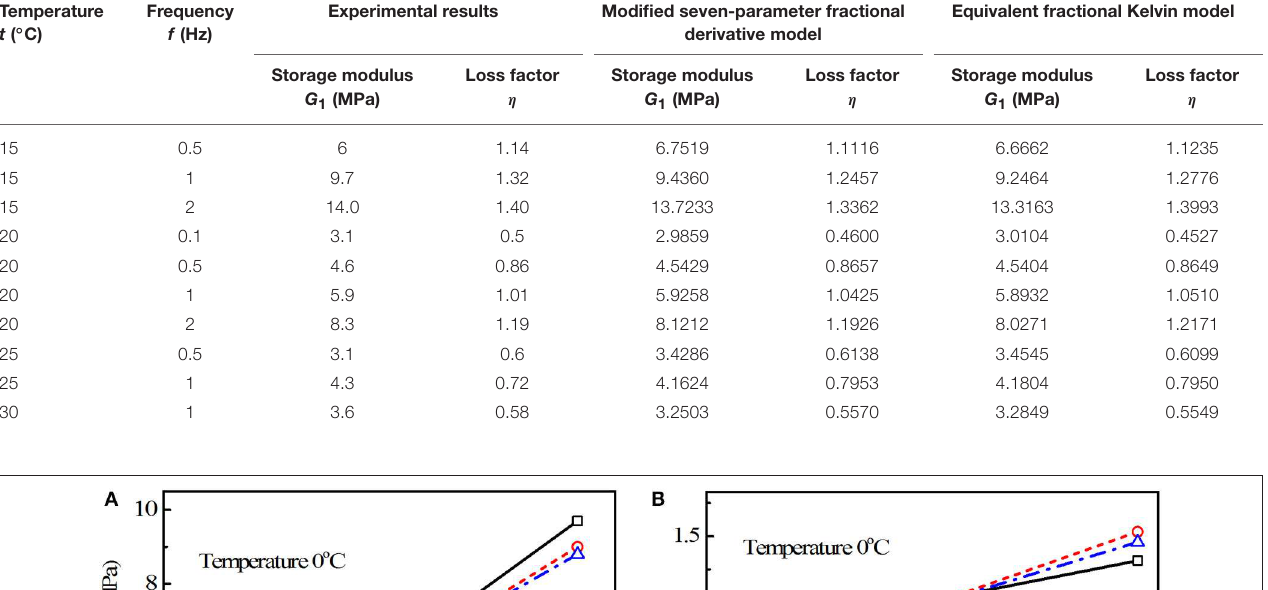
TABLE 5 | Experimental and numerical results comparison for Zn22 viscoelastic material. Temperature t ( ◦ C)